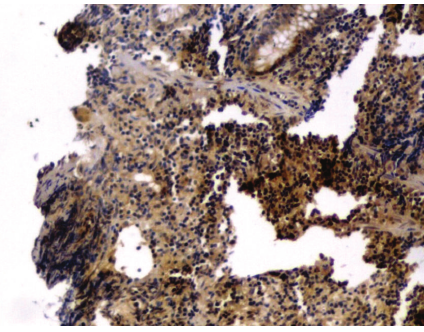
Figure 6: Positive particle for anti-IL-1 β (1 ×